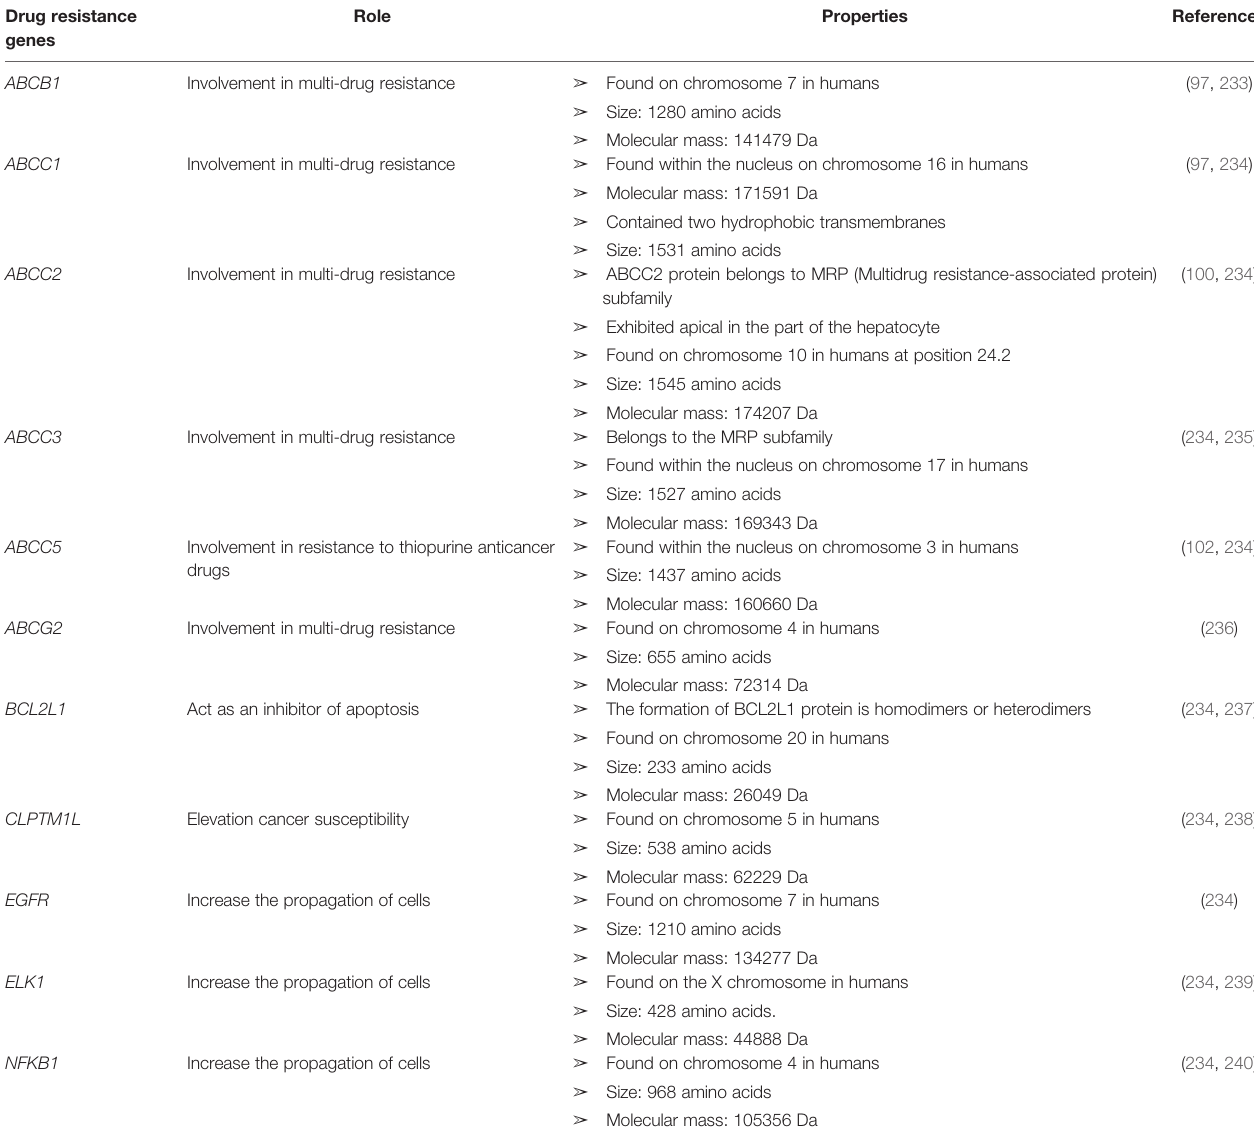
TABLE 2 | List of some cancer drug-resistant genes with their role and properties. Drug resistance